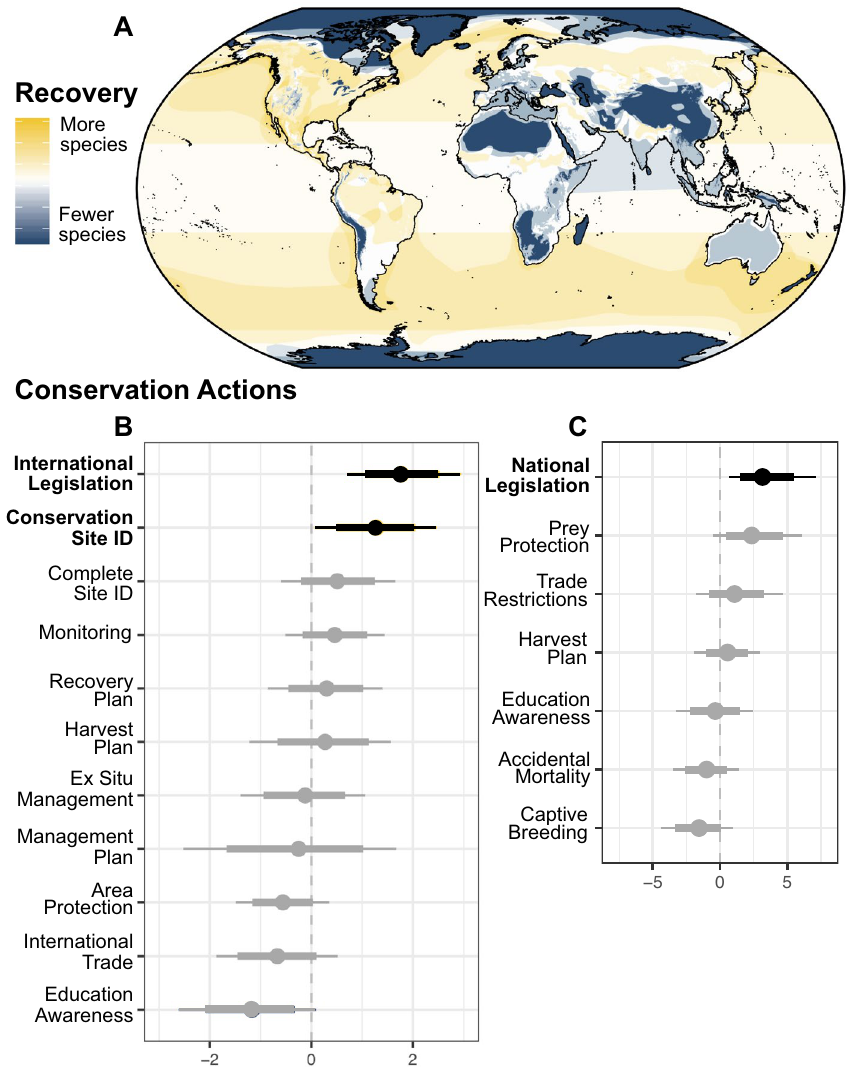
Figure 4. Large carnivore recoveries and associations with conservation actions. ( A ) Geographic variation in the number of large carnivore recoveries, defined as an increasing population trend or improvement in status since initial IUCN assessment (cumulatively, recovery metrics ). IUCN range maps of species meeting either criterion were overlaid, and color indicates the absolute number of recovering species in each 5 km cell. ( B ) For IUCN-defined ‘Conservation actions in-place,’ the change in the log-odds of showing an increasing trend for species subject to each conservation action (see Table S5 for definitions). Points to the right of the dashed vertical line (black) indicate a significant positive association, Gray points indicate that confidence intervals overlap zero. Parameter estimates are coefficients of a binomial logistic regression model (with all other conservation actions included), 95% confidence intervals (thin lines), and 90% confidence intervals (thick lines). ( C ) For author-defined conservation actions (see “Methods”, Table S5), the change in the log-odds of a positive outcome of either recovery metrics. Not shown: IUCN-defined actions and improved status (significant positive associations: International Legislation and Harvest